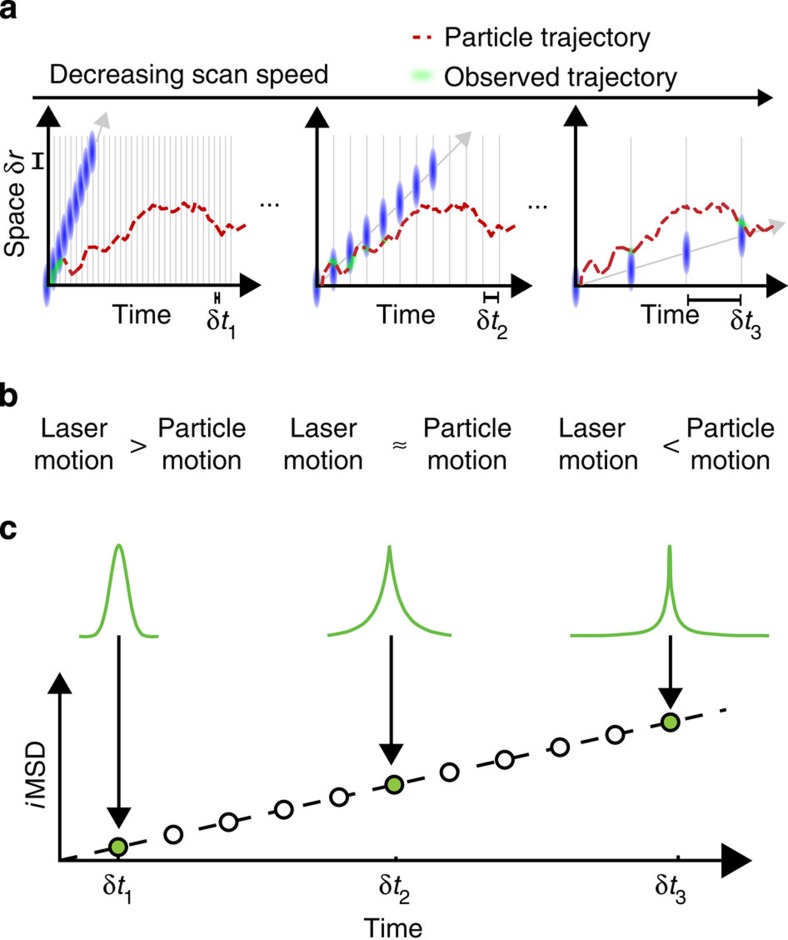
iMSD analysis of molecular motion in 3D: GFP Brownian diffusion in dilute solution.(a) Pictured experiment: ‘fluorescent’ molecules freely diffuse distributing in space and time. Scanning the samples with decreasing speed allows measuring the average particle displacements over a wide spatiotemporal scale. (b) When the scanning is faster than the particle dynamics, the particle image corresponds to the autoconvolution of the instrumental point spread function, which is well approximated by a Gaussian profile. On the other hand, when scanning speed decreases, the particle starts to move significantly, that is, the correlation function squeezes in space becoming much larger than the PSF. Equation 15 in Supplementary Information describes this deformation effect as a function of the particle average displacement, and allows recovering the iMSD as a function of time delay. (c) Schematic representation of the iMSD for a molecule diffusing in 3D.